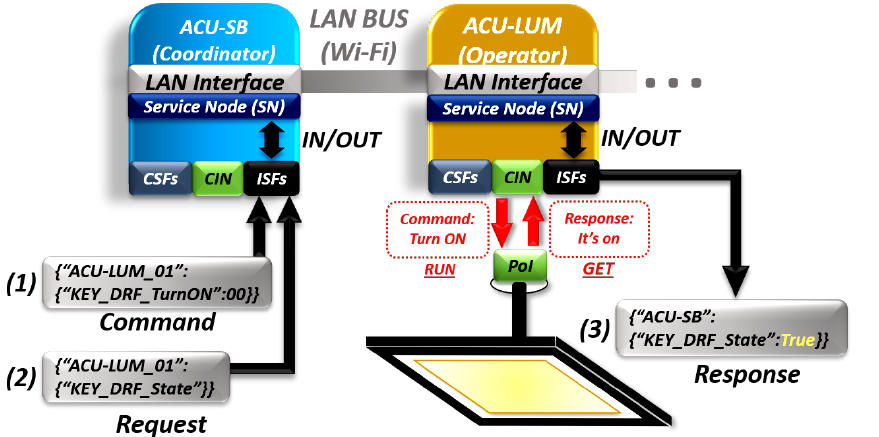
Figure 5. Examples of command (1), request (2), and response (3) used in the communication of the proposed